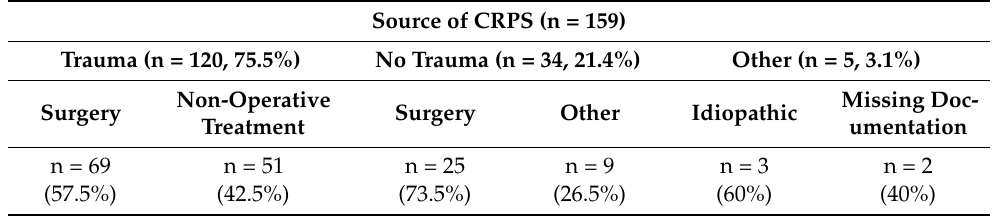
Table 1. Summary of the occurrence of CRPS.